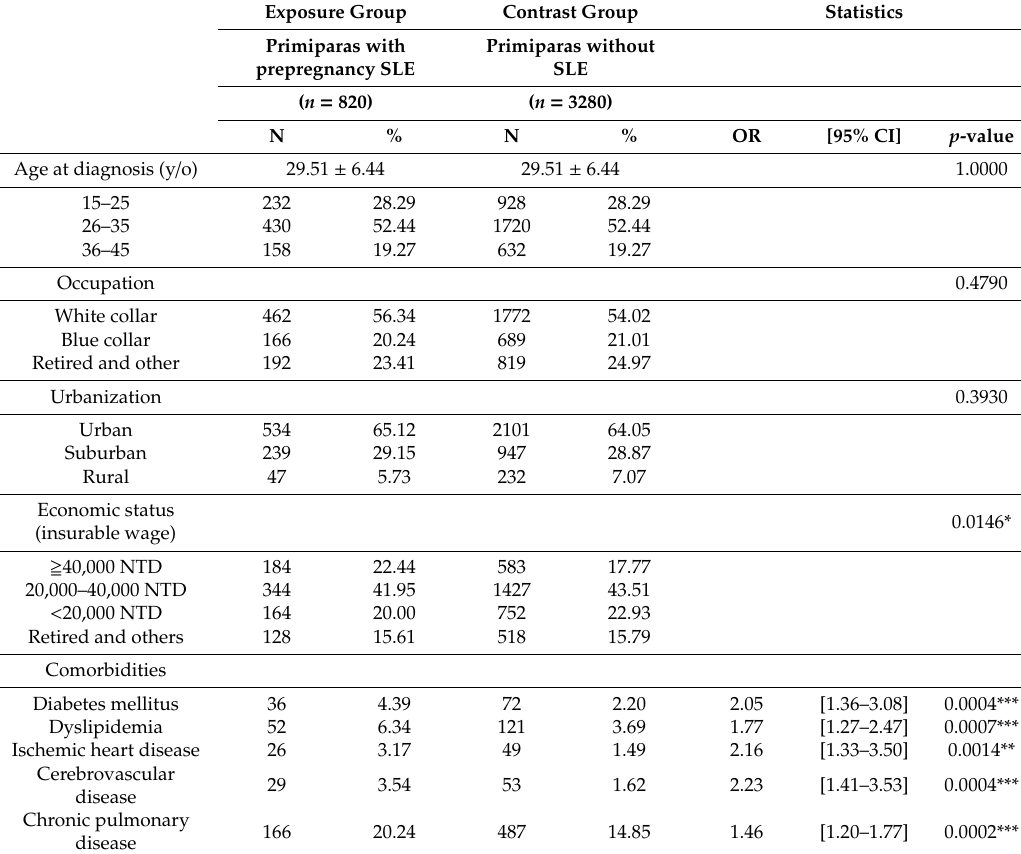
Table 2. Comparisons of the characteristics between the exposure (prepregnancy SLE) and contrast (no SLE) groups. Exposure Group Contrast Group Statistics Primiparas with Primiparas without prepregnancy SLE SLE ( n = 820) ( n = 3280) N % N % OR [95% CI] p -value Age at diagnosis (y /